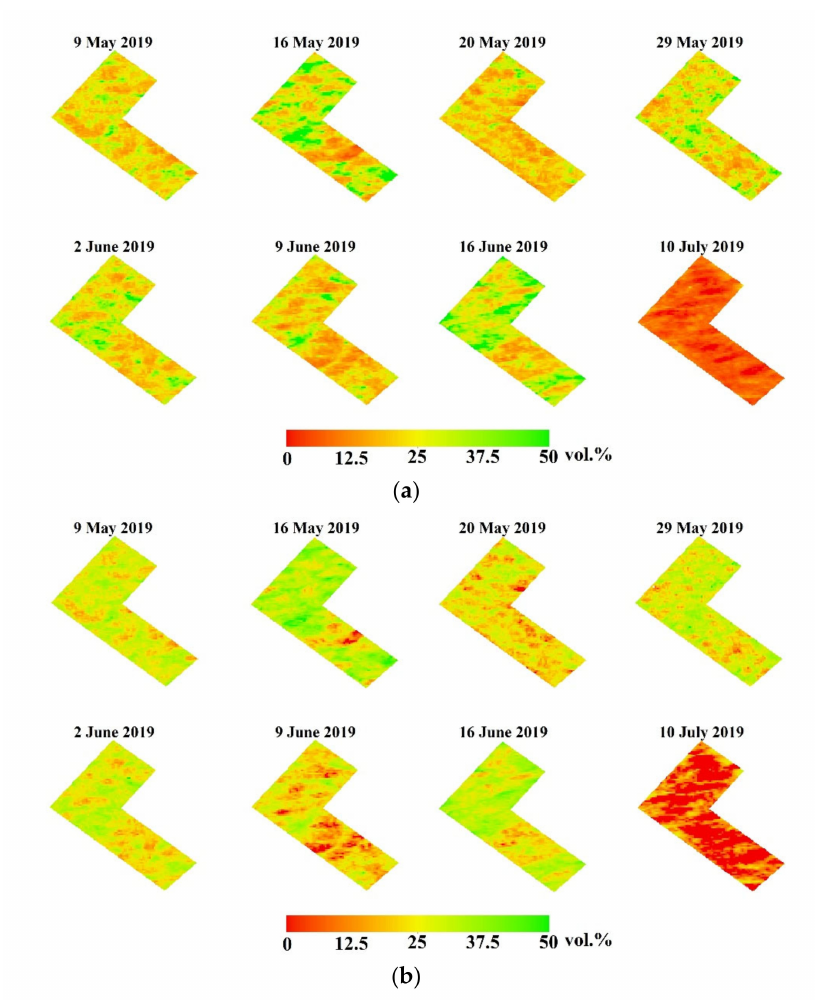
Figure 14. Soil moisture map for the study area ( a ) CIEM-SMC map; ( b ) Dubois-SMC map. The range of the soil moisture is large (0–50 vol.%), which is an obvious deviation from the actual situation. This is attributed to the use of optimal roughness